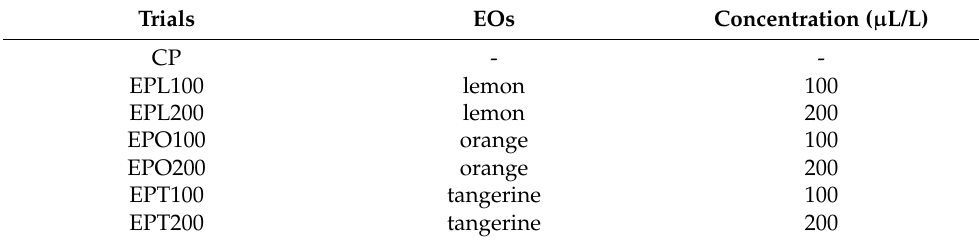
Table 1. Cheese productions.